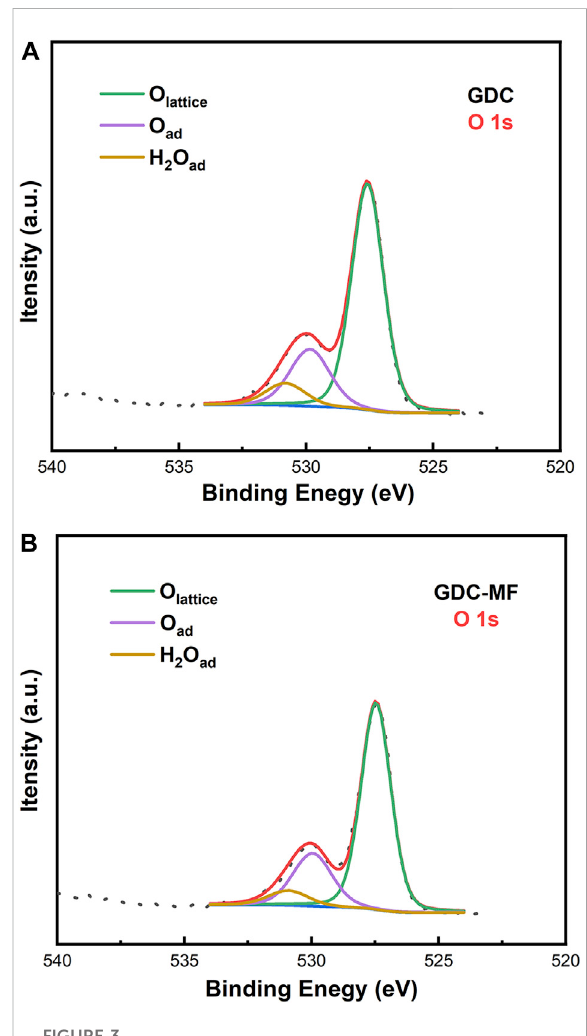
FIGURE 3 XPS spectra of O 1s for (A) GDC and (B) GDC-MF